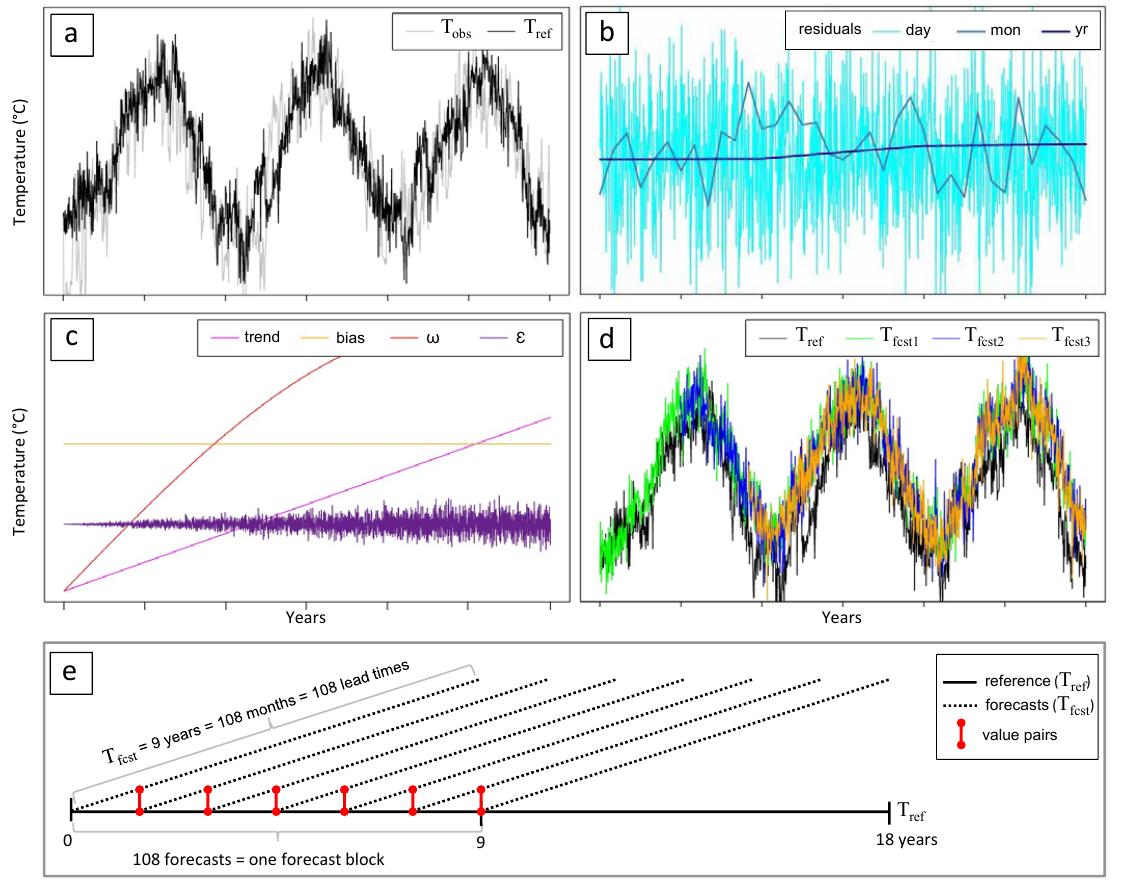
Figure 3. Methodology used to produce the synthetic weather forecasts. ( a ) Observed temperature time series ( T obs ) and reference time series produced with the weather generator ( T ref ). ( b ) Decomposition of the residuals of T obs in a daily, monthly and yearly variability. ( c ) Trend, bias, oscillation ( ω ) and noise ( ε ) added to T ref to generate the ( d ) synthetic forecasts ( T fcst ). ( e ) Illustration of a forecast block composed of 108 forecasts of 9 years in length, as well as the value pairs used to calculate the skill scores (Section 2.4). The values pairs are shown for lead time 1, meaning that the values of the meteorological forecasts and the ones of the reference time series are paired after one month. The scales in the figure are arbitrary and are meant for illustration purposes